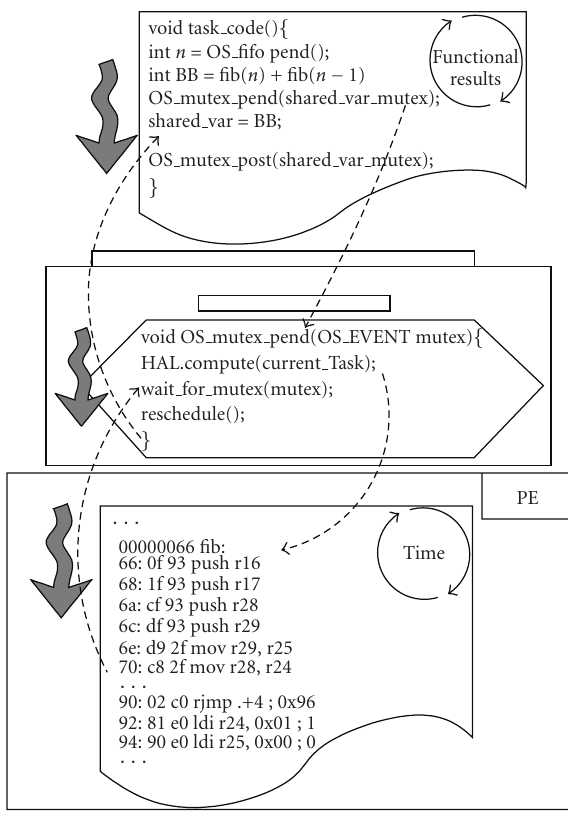
Figure 12: Example of a Simulation Couple. The software part of the application has two representations: a functionnal one used in high level abstraction layer and a timed one based on the use of an